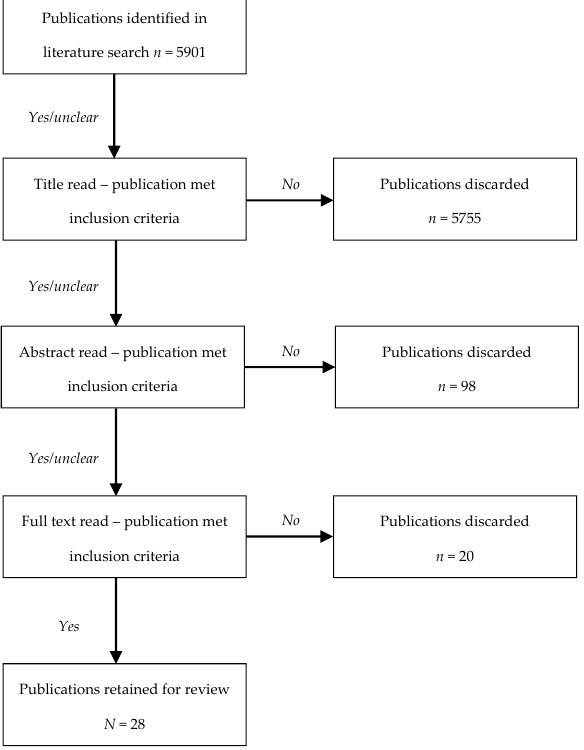
Figure 1. Flow chart for each step of article evaluation and retainment.